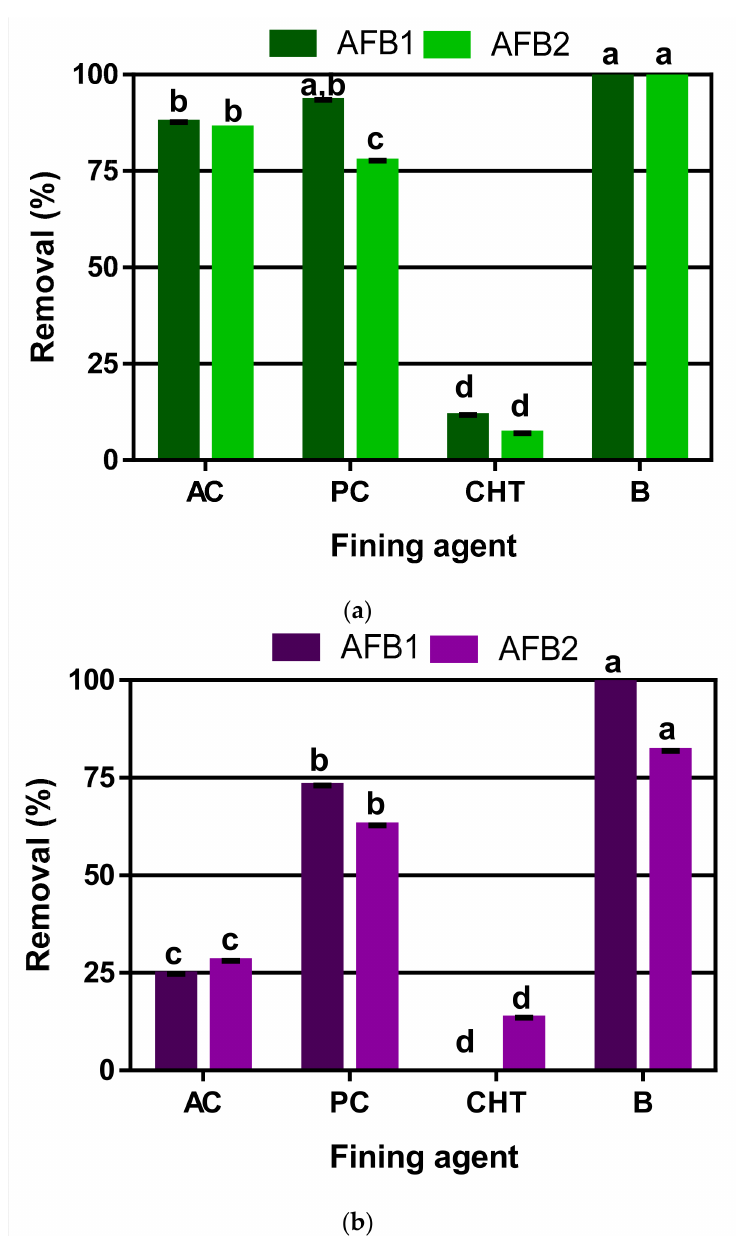
Figure 1. Removal of aflatoxins B1 (AFB1) and B2 (AFB2) in white ( a ) and red wine ( b ) using di ff erent fining agents. Means within a column for each wine, followed by the same letter are not significantly di ff erent (Tukey p < 0.05). AC—Activated Carbon; PC—Potassium